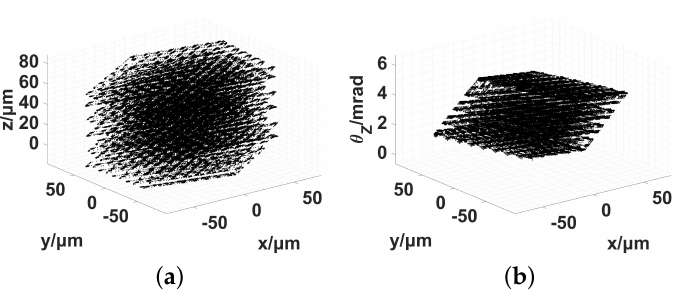
Figure 17. Workspace of the 6-RRRR NPS using a 3D view. ( a ) x − y − z; ( b ) x − y − θ z.